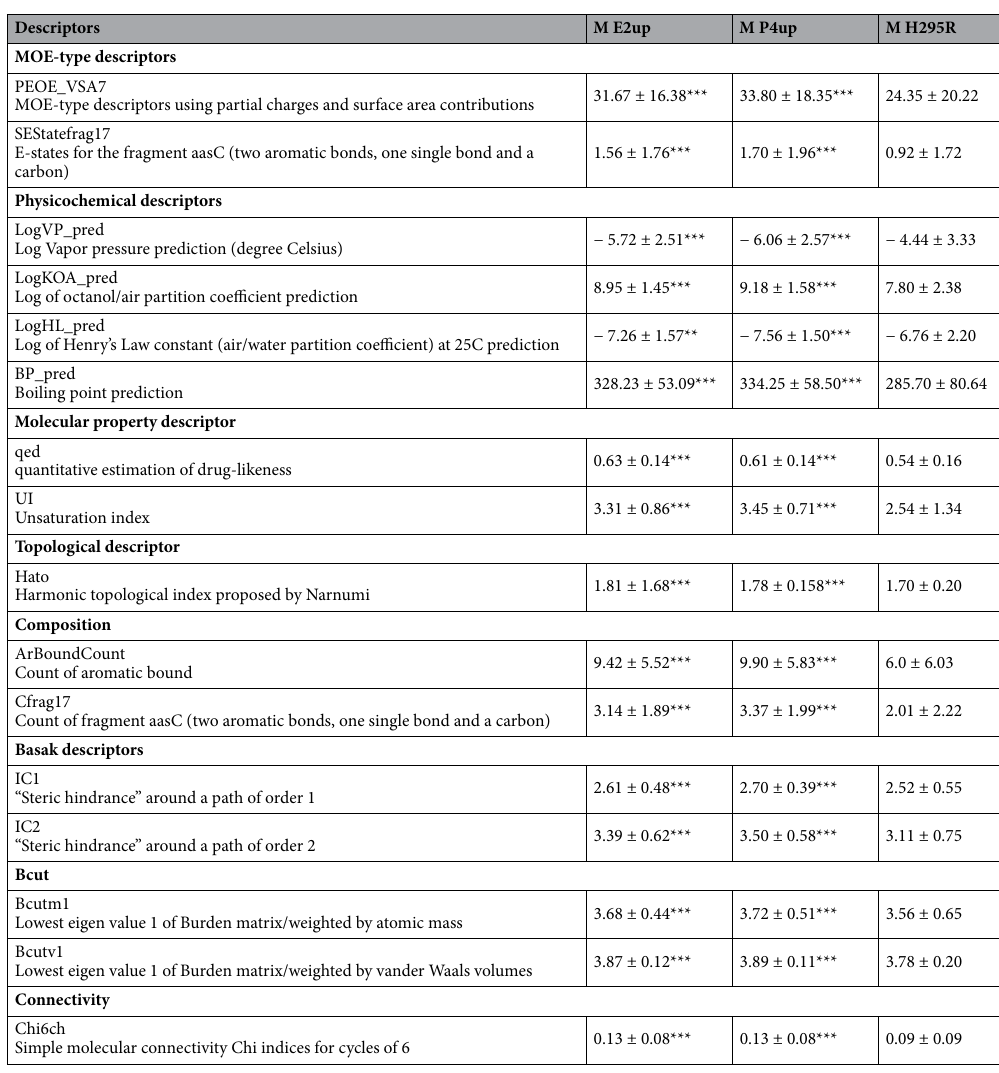
Table 4. Details of the Top 10 descriptors from the best RF models, including average (M) of the descriptor values for each group of E2up, P4up and H295R, with an associated p-value significance (*** < 0.005). Student- test or Wilcoxon test (if descriptor distribution was not normal) were